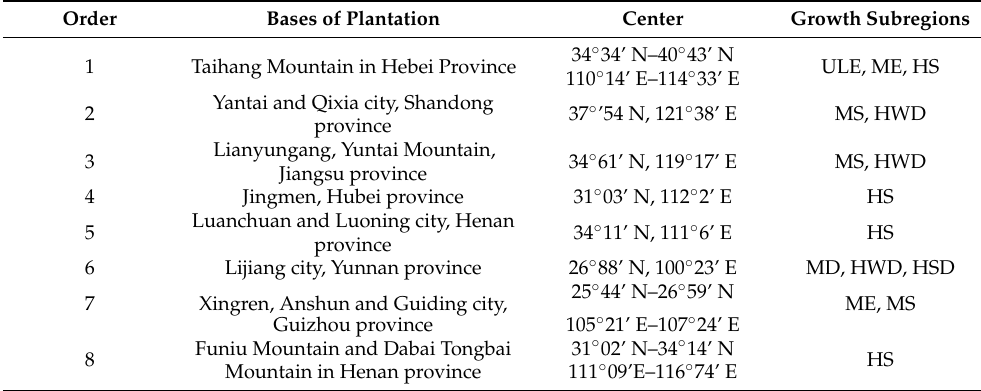
Table 8. The growth subregions of the main bases for C. bungei plantation. For the abbreviation of growth subregions, see Figure 5. Order Bases of Plantation